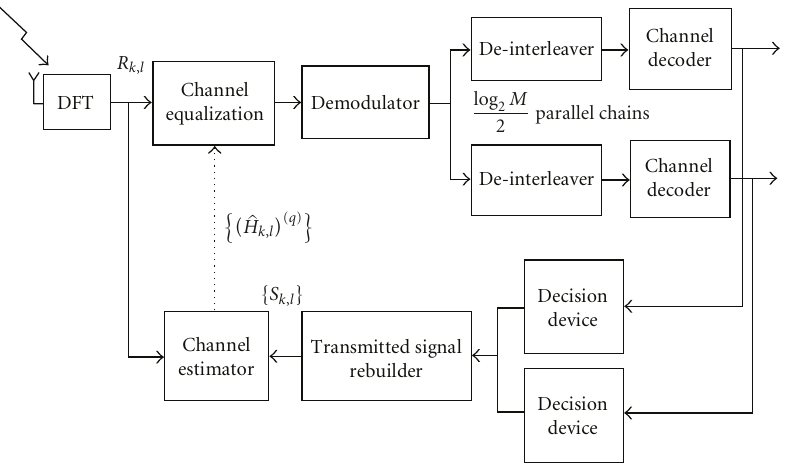
Figure 3: Iterative receiver structure